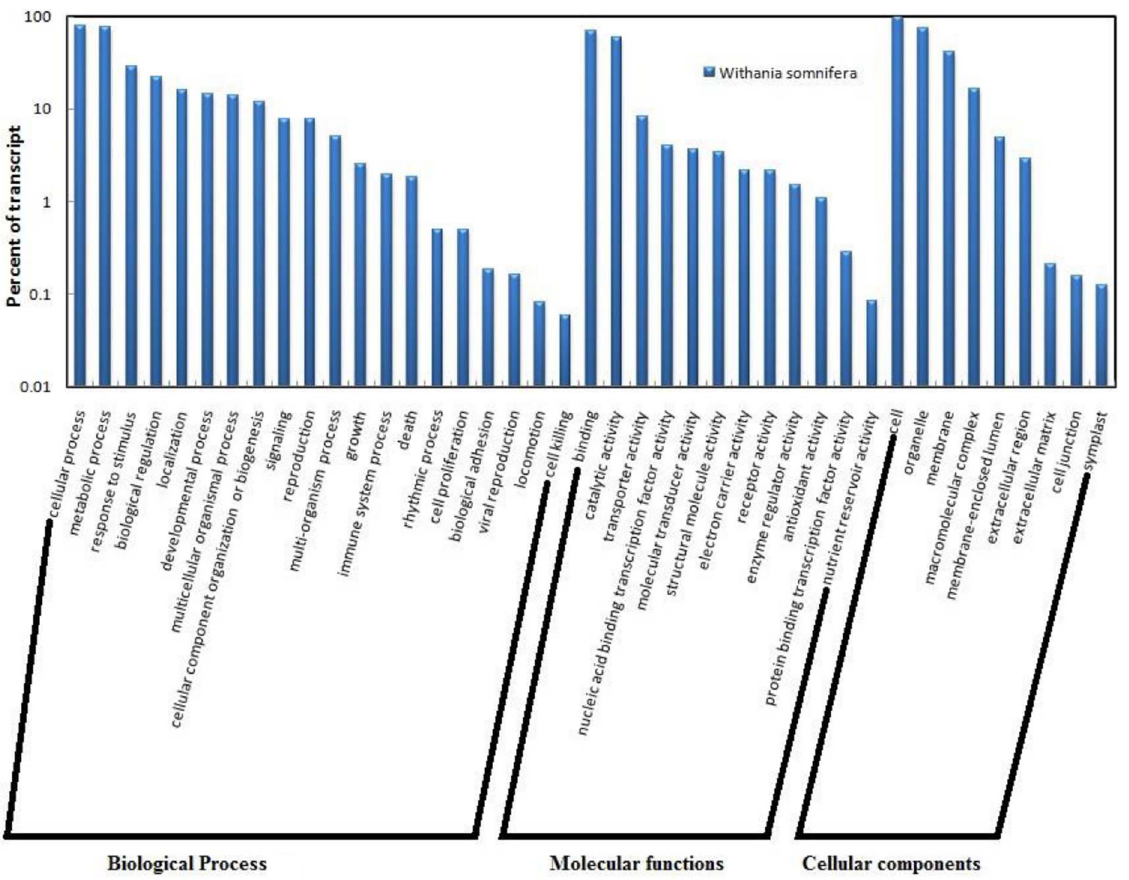
Figure 3. Gene Ontology classification of transcript contigs grouped under biological processes, molecular functions and cellular components.